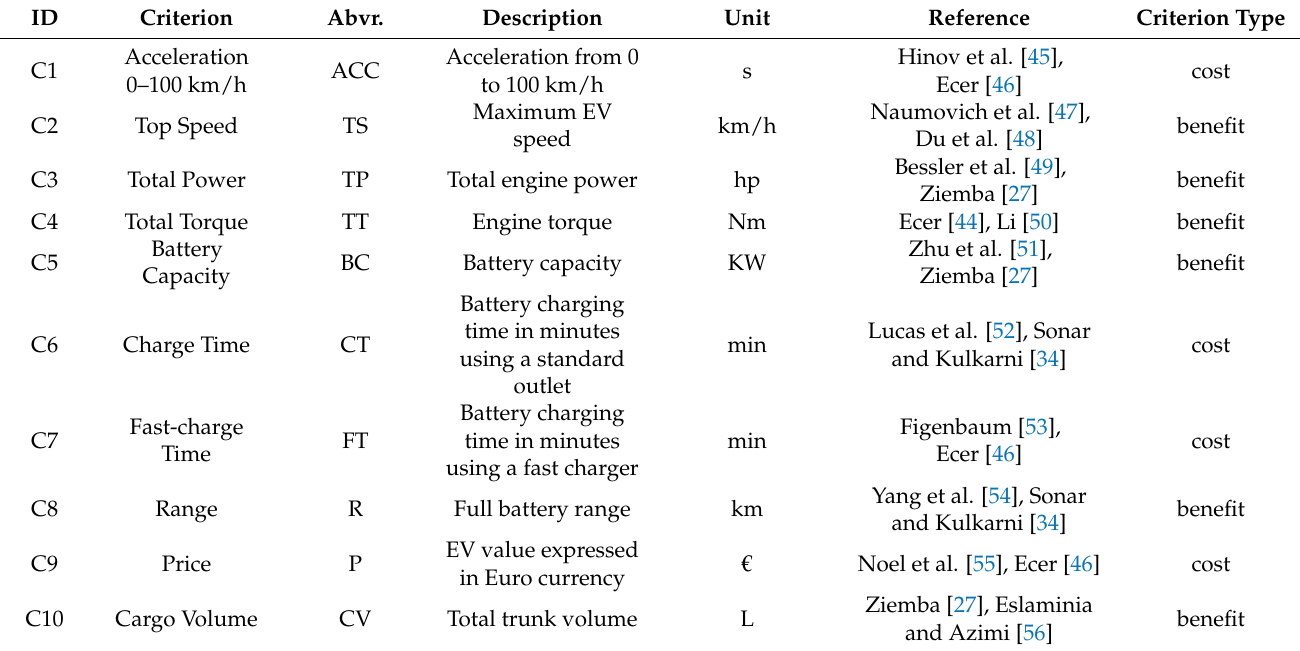
Table 2. The criteria used to evaluate